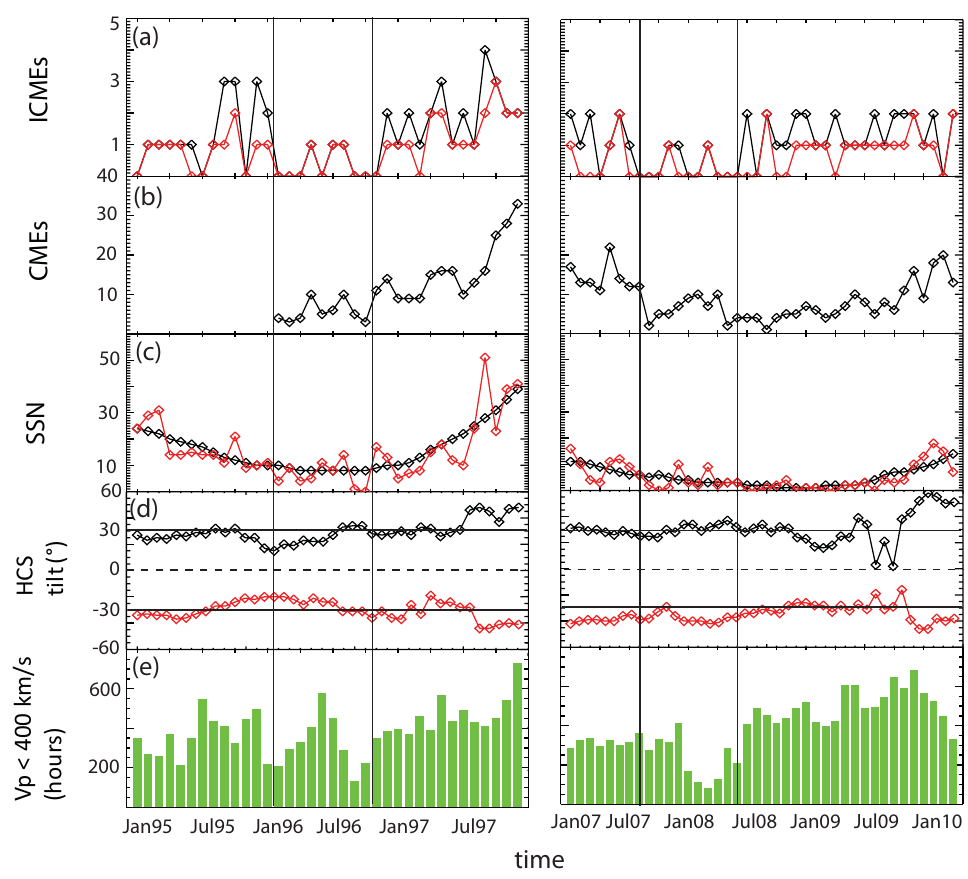
Fig. 2. Monthly ICME rate and solar activity. Panels show: rate of (a) ICMEs (black) and the subset of ICMEs that have B max > 7nT and D ICME > 0 . 1AU (red) (b) CMEs with angular extent > 50 ◦ from the LASCO CME catalogue, (c) monthly (red) and monthly smoothed (black) sunspot number from SIDC, (d) maximum northern (black) and southern (red) latitudinal extent of the streamer belt neutral line cal- culated using source surface at 1.8 R S in the PFSS model, (e) monthly distributions of periods (in hours) with solar wind speed < 400kms − 1 . The periods of the minimum ICME rates are bounded between two vertical